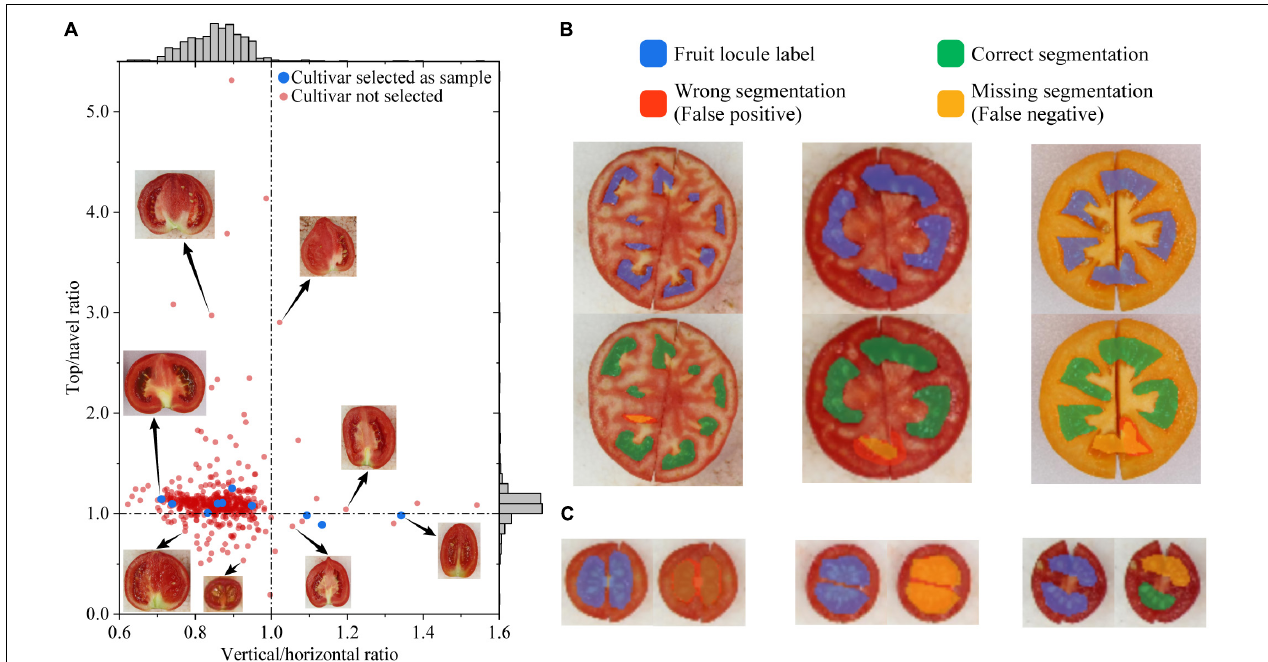
FIGURE 5 | Evaluation of tomato fruit phenotyping indicators and fruit locule segmentation. (A) Distribution of top/navel ratio against horizontal/vertical ratio among cultivars; the dashed line refers to the corresponding value equals one; (B) Incorrect segmentation cases that do the correct locule counting; (C) Incorrect segmentation cases caused by hazy septum. Fruit images are not